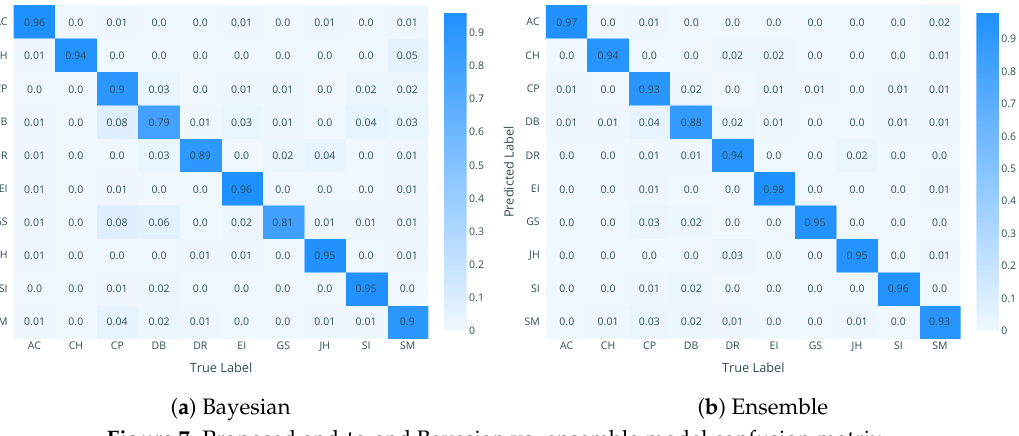
Figure 6. Area under the ROC curve (AUC) of predictor model.